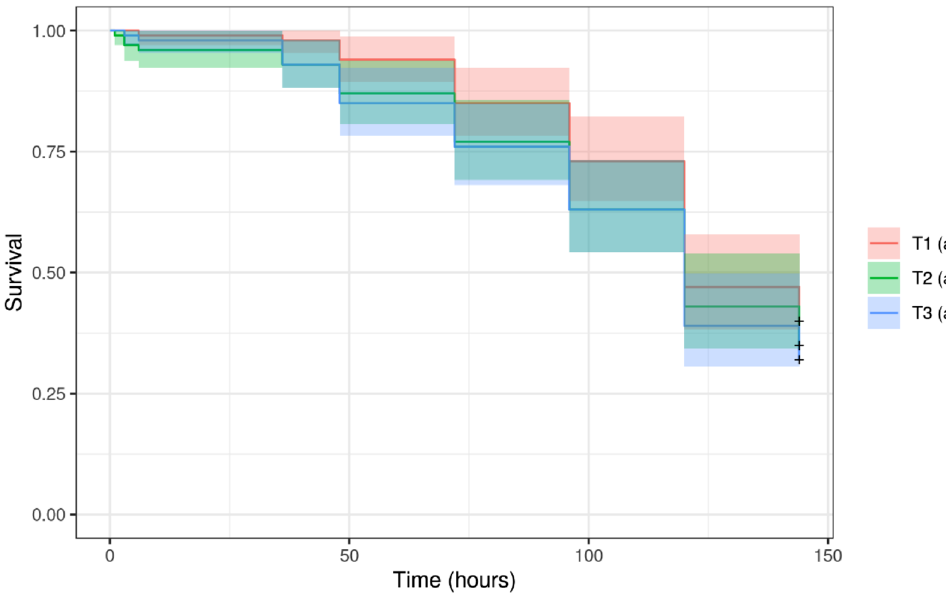
Figure 2. Graph of survival of foragers bees ( A. mellifera ) , by Kaplan–Meier, adjusted to the period (h) after feeding with Candi paste incorporating commercial products (T2, Dipel; T3, Xentari) or the control diet (T1). Temperature (26 °C ± 2 °C, RH 60% ± 10%; 12-h photoperiod). The same letters indicate that there was no significant difference between the results ( p <